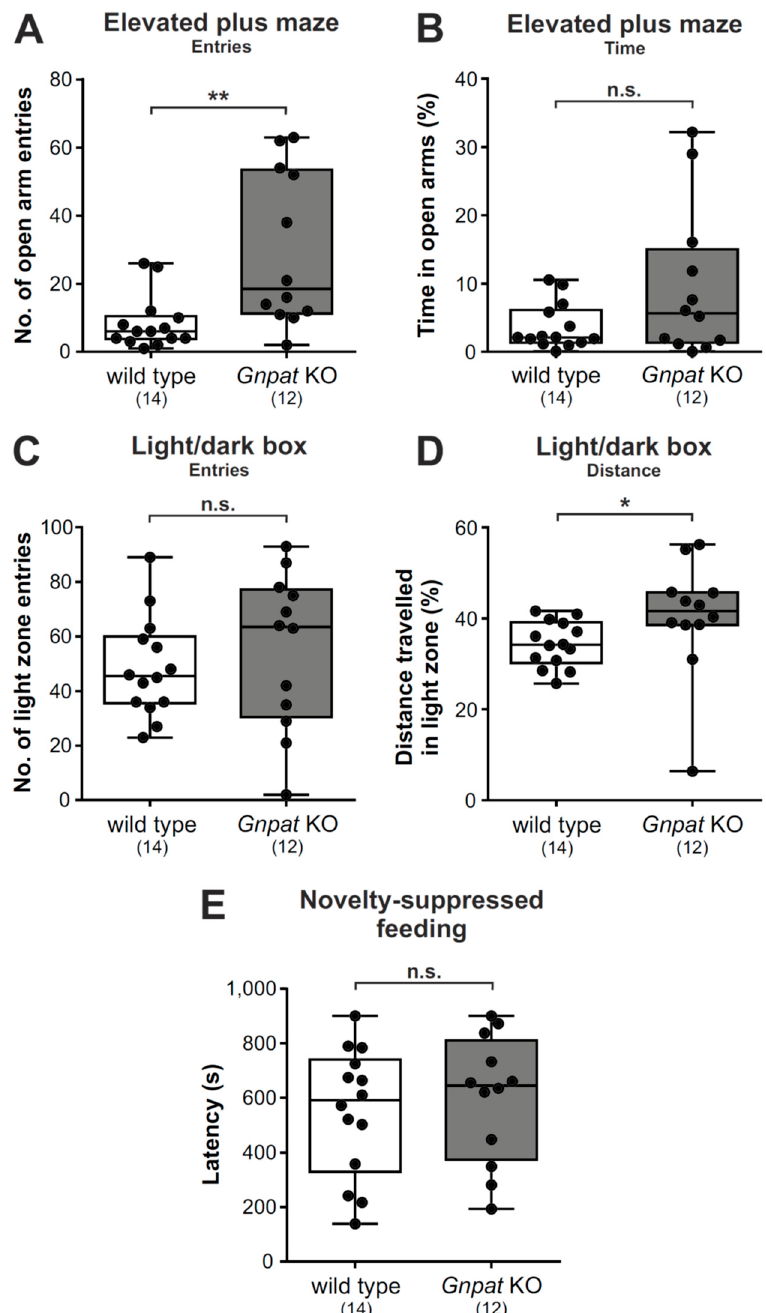
Figure 4. Elevated plus maze and light / dark box testing suggest slightly reduced levels of anxiety in Gnpat KO mice: WT and Gnpat KO mice were tested in the elevated plus maze paradigm and the number of entries ( A ) as well as the time spent in open arms ( B ) were analyzed. Number of entries ( C ) and distance travelled in the light zone ( D ) by WT and Gnpat KO mice are shown as percentages of the total distance travelled during the trial in the light / dark box test. ( E ) Latency in the novelty-suppressed feeding test in WT and Gnpat KO mice is depicted. Data are shown as box plots together with individual data points, and whiskers indicate minimal and maximal values (all panels). The number of tested animals is given in brackets. Statistical analysis was done using the Mann–Whitney U test (Figure 4A–D) and two-tailed Student’s t -test (Figure 4E). ** p < 0.01, * p < 0.05; n.s. , not significant .